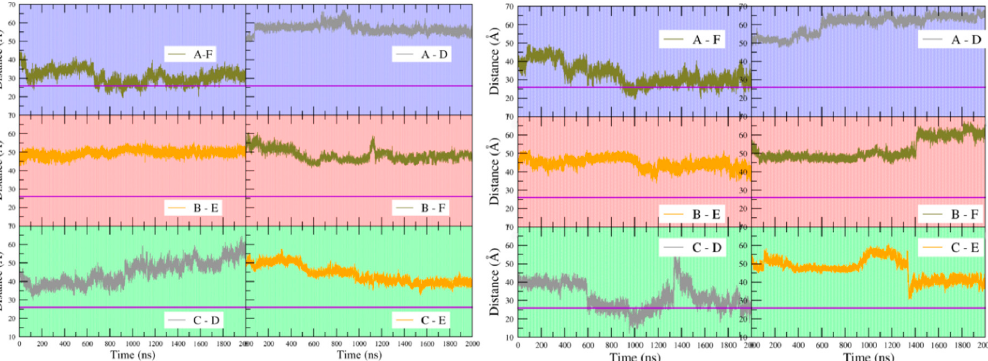
Figure 9. Distance between N-terminal domain pairs. The distance between C α atoms of residue Arg43 in neighboring N-terminal domains was calculated during the time course of the simulations. The background color of each panel corresponds to one monomer of one trimer (A, B, or C; blue, red, or green) as in Figure 3. The colored lines on each panel indicate the N-terminal domain from the other trimer (D, E, or F; grey, orange, or tan) as in Figure 3. Left six panels, apoBsArgR; right six panels,